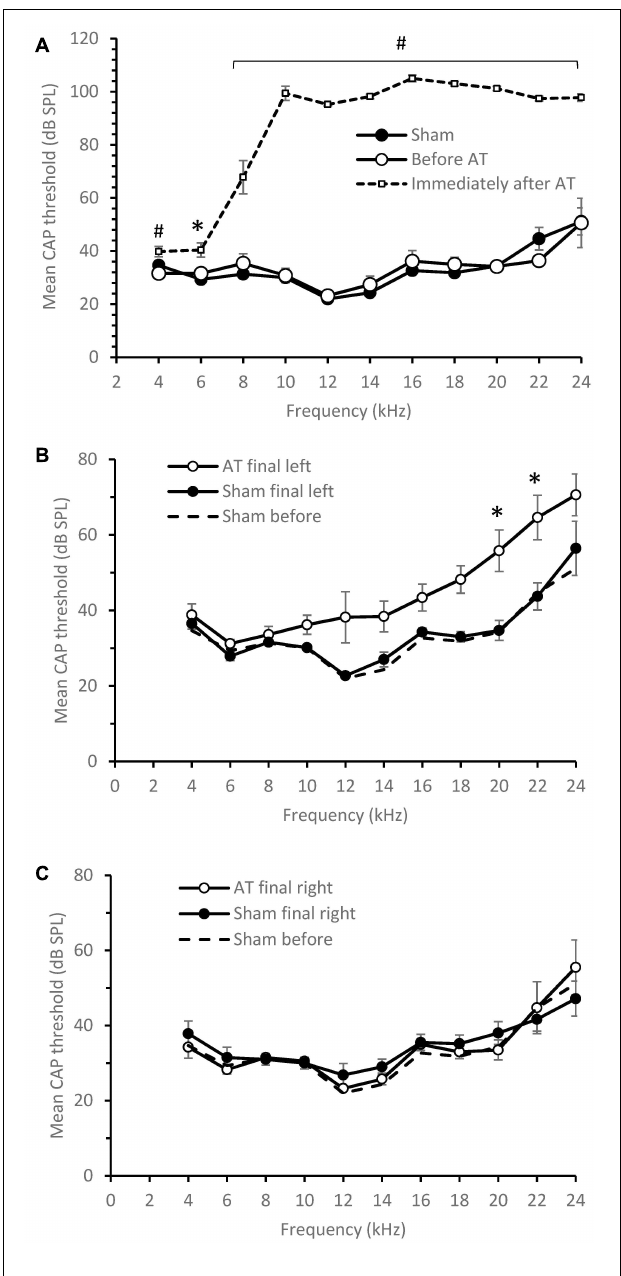
FIGURE 1 | CAP threshold audiograms. (A) Mean CAP threshold left ear vs. frequency at the time of initial surgery, Sham animals ( n = 6), AT animals before and after AT ( n = 5). Significance between Immediately after and before AT indicated. (B) Mean CAP threshold left ear vs. frequency at the time of final surgery, Sham animals ( n = 6), AT animals ( n = 5). (C) Mean CAP threshold right ear vs. frequency at the time of final surgery, Sham animals ( n = 6), AT animals ( n = 4). For comparison the sham audiogram at initial surgery also plotted as a dotted line in (B,C) . Data Mean ± SEM. ∗ p < 0.05, # p < 0.01.